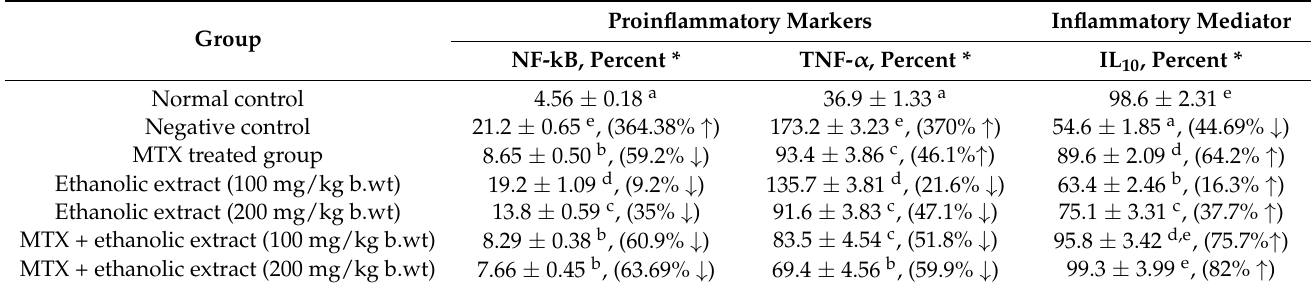
Table 2. Effect of different treatments on the levels of markers of inflammation (NF-kB, TNF- α and IL-10).